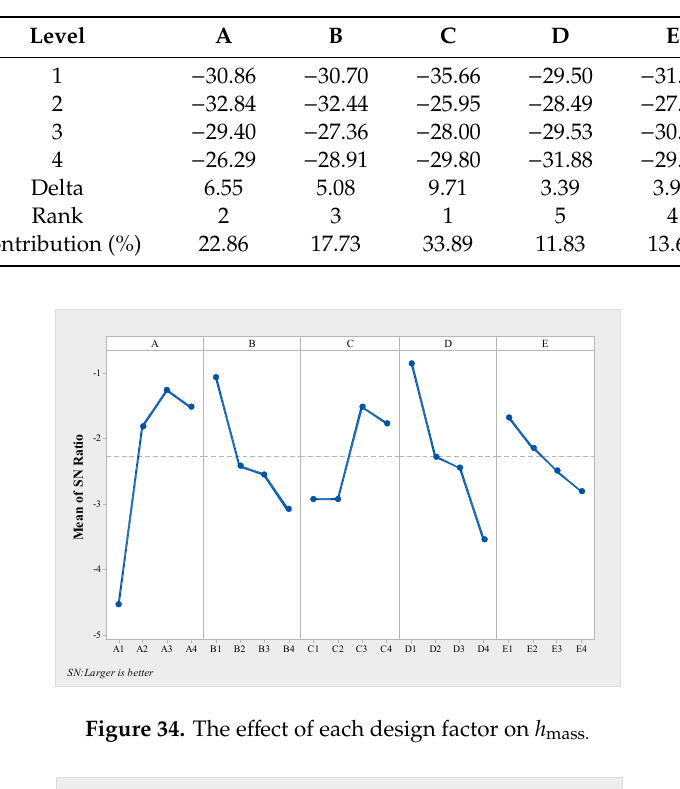
Figure 35. The effect of each design factor on Fr.